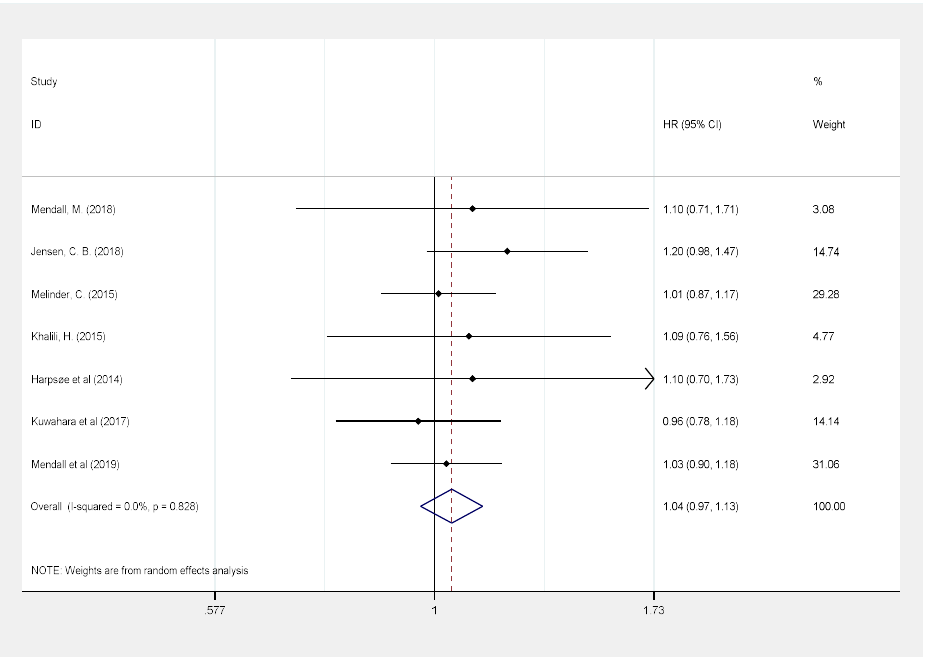
Figure 5. Association between underweight (BMI <18.5 kg/m 2 ) and risk of ulcerative colitis.